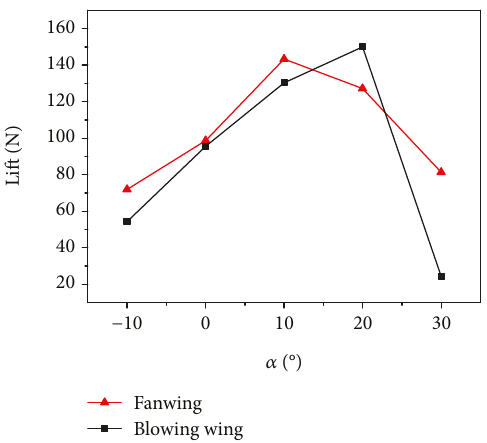
Figure 15: Lift curve changes with the angle of attack.